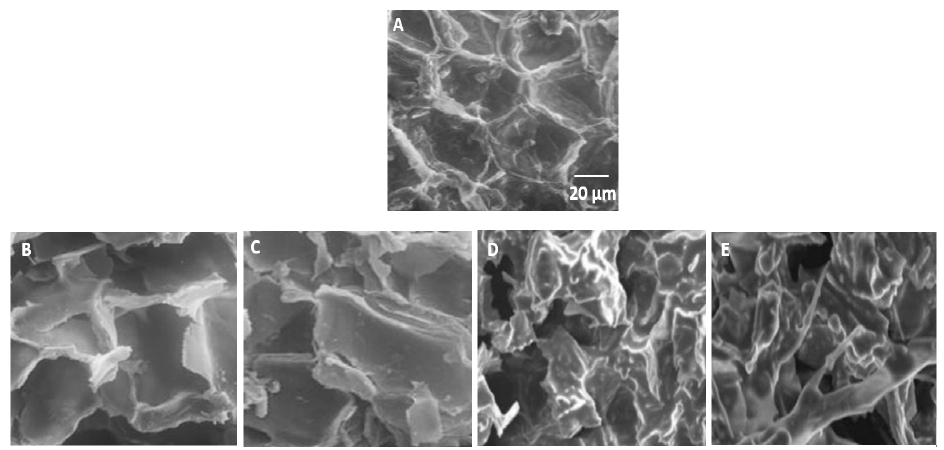
Figure 4. Scanning electron microscopy images of E. alata powder: control sample before extraction ( A ), Soxhlet ( B , C ), and UAE ( D , E ). ( A ), Soxhlet ( B , C ), and UAE ( D , E